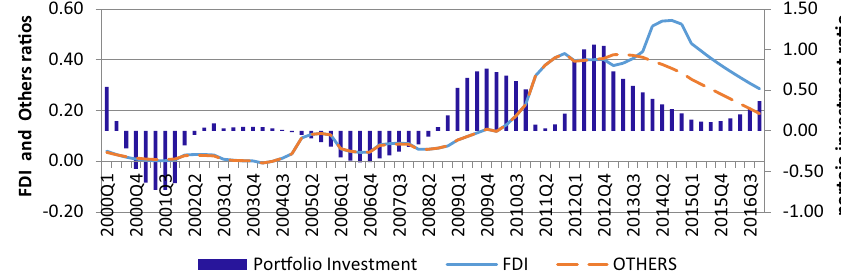
Figure 1. Components of capital flow values in millions US